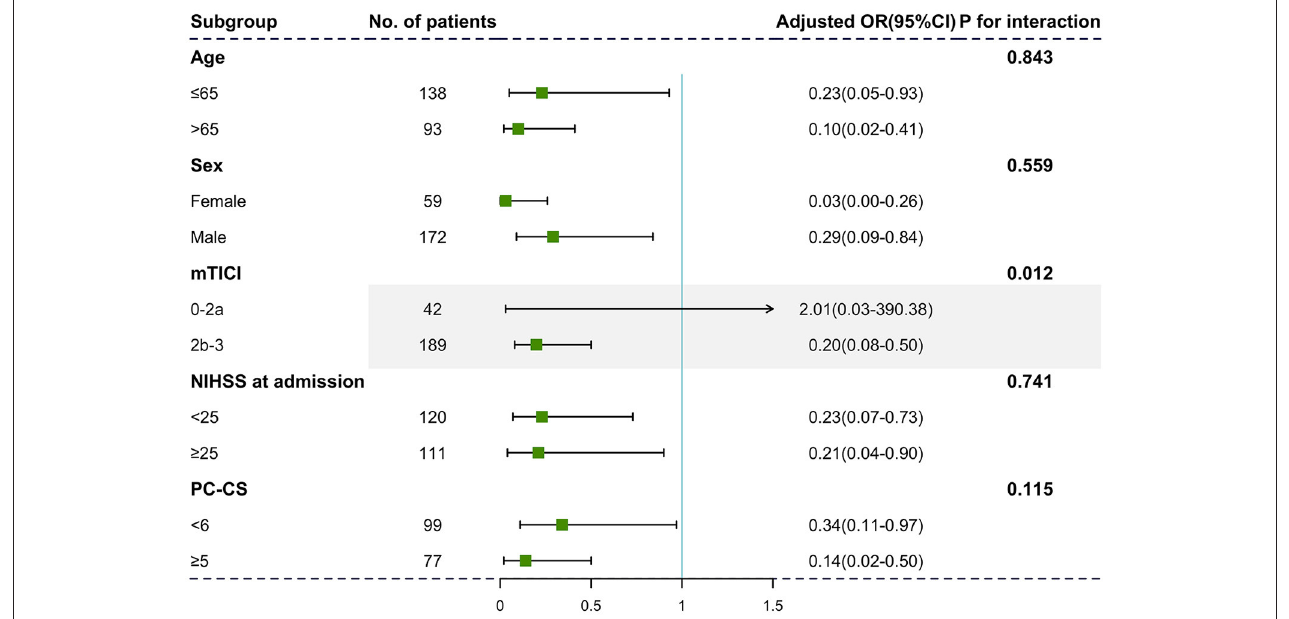
FIGURE 2 | Subgroup analyses of primary outcomes. The forest plot showed the differences in odds ratios for favorable outcomes (defined as the modified Rankin Scale score of 0–3) at 3 months in the prespecified subgroups. Adjusted variables are as follows: age, sex, dyslipidemia, atrial fibrillation, baseline NIHSS score, baseline PC-ASPECTS, mTICI, PC-CS, and onset to recanalization